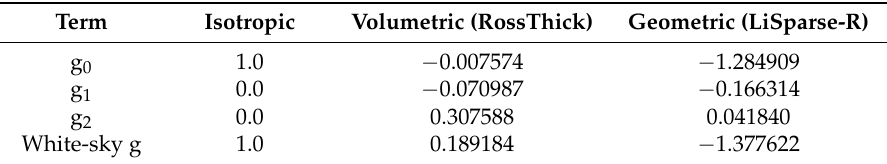
Table 2. The numeric g coefficients for Bidirectional Reflectance Distribution Function (BRDF) inversion from Reference [23]. The rows and columns here combine to form the various terms in Equations (4) and (5), for example, the first column and row represent the g 0I S O term. Term Isotropic Volumetric